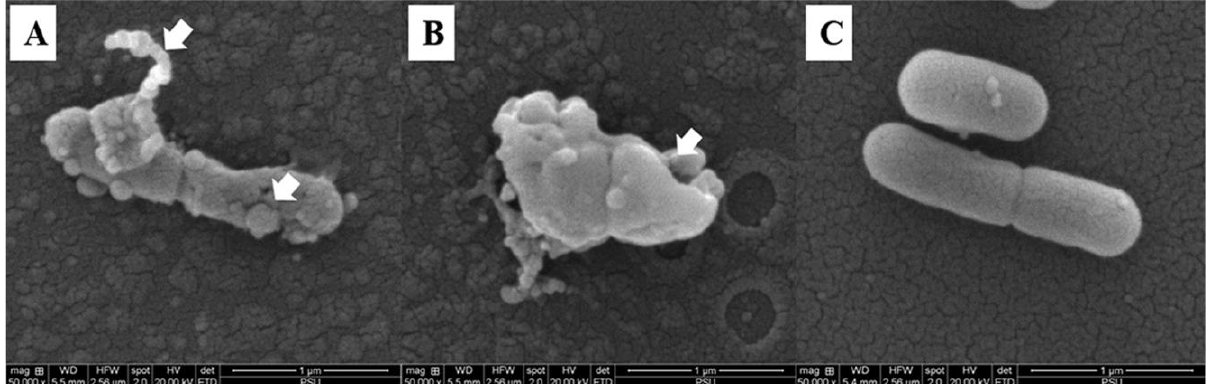
Figure 8. Scanning electron microscopic (SEM) images of L. monocytogenes treated with 4 × MIC of COS-EGCG conjugate ( A , B ) and treated with 0.01% acetic acid (negative control) ( C ). The magnification was 50,000×. Arrow signs indicate the distortion of flagella and rough surfaces ( A ) and cell surface damage with pores ( B ).